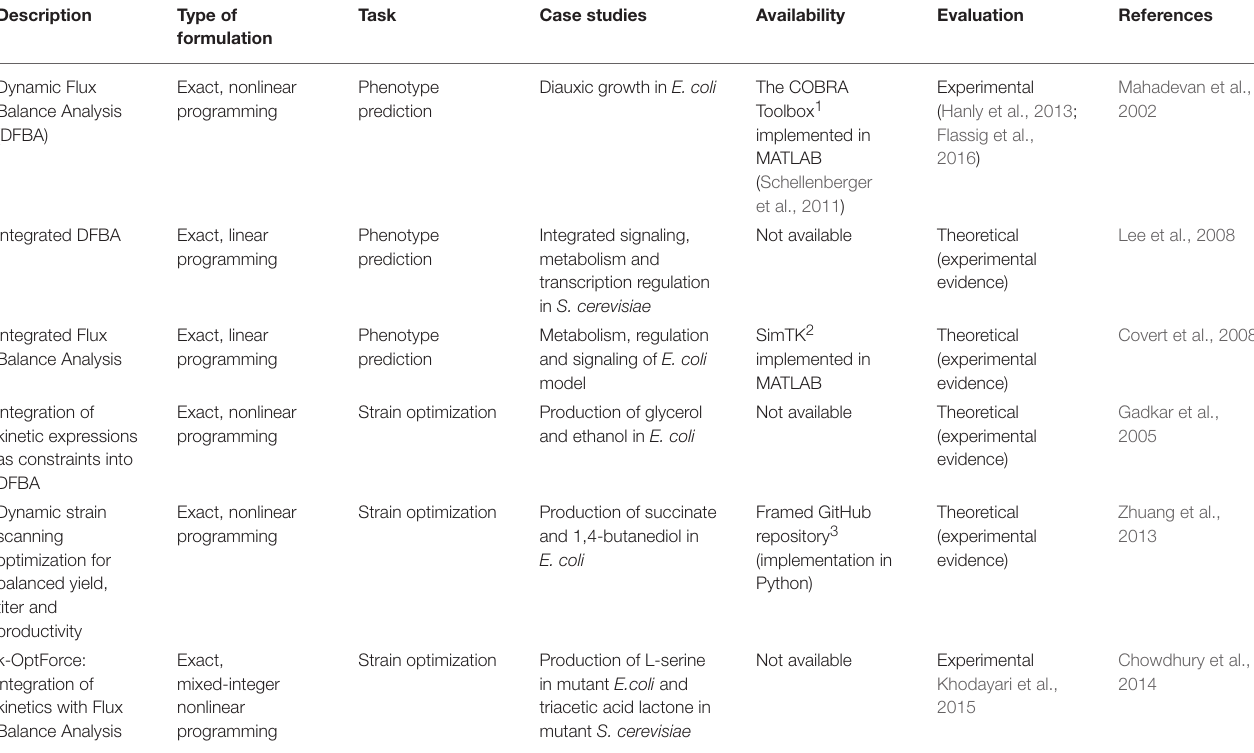
TABLE 3 | Examples of hybrid models used only for phenotype prediction or for computational strain